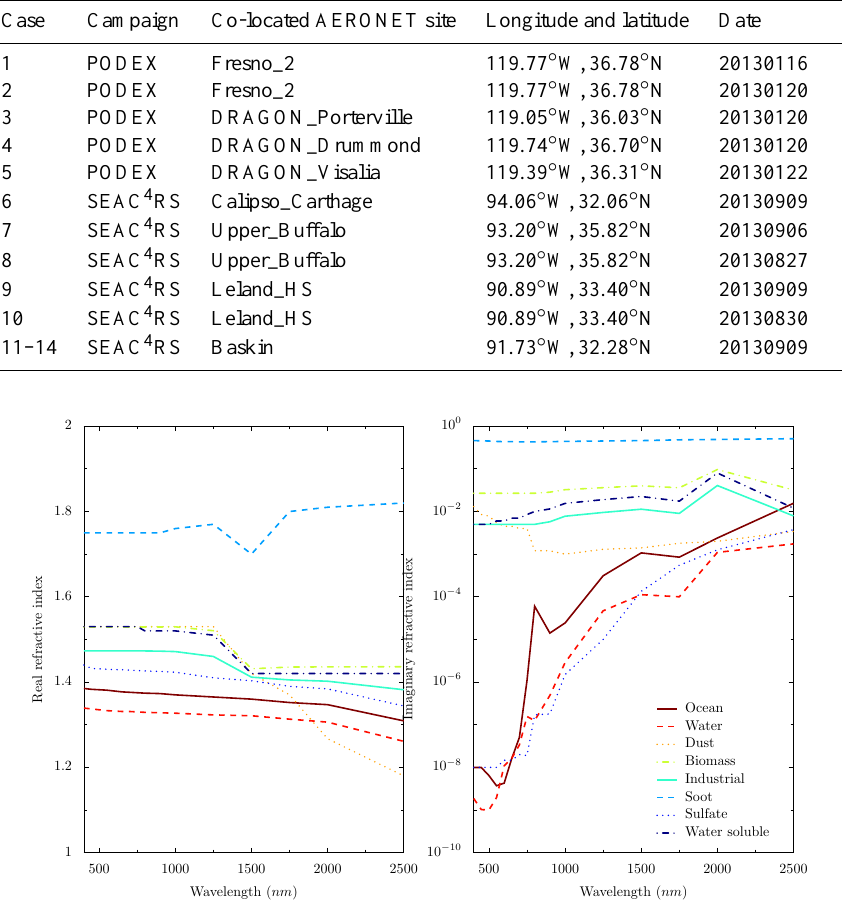
Table 1. Information of used RSP measurements